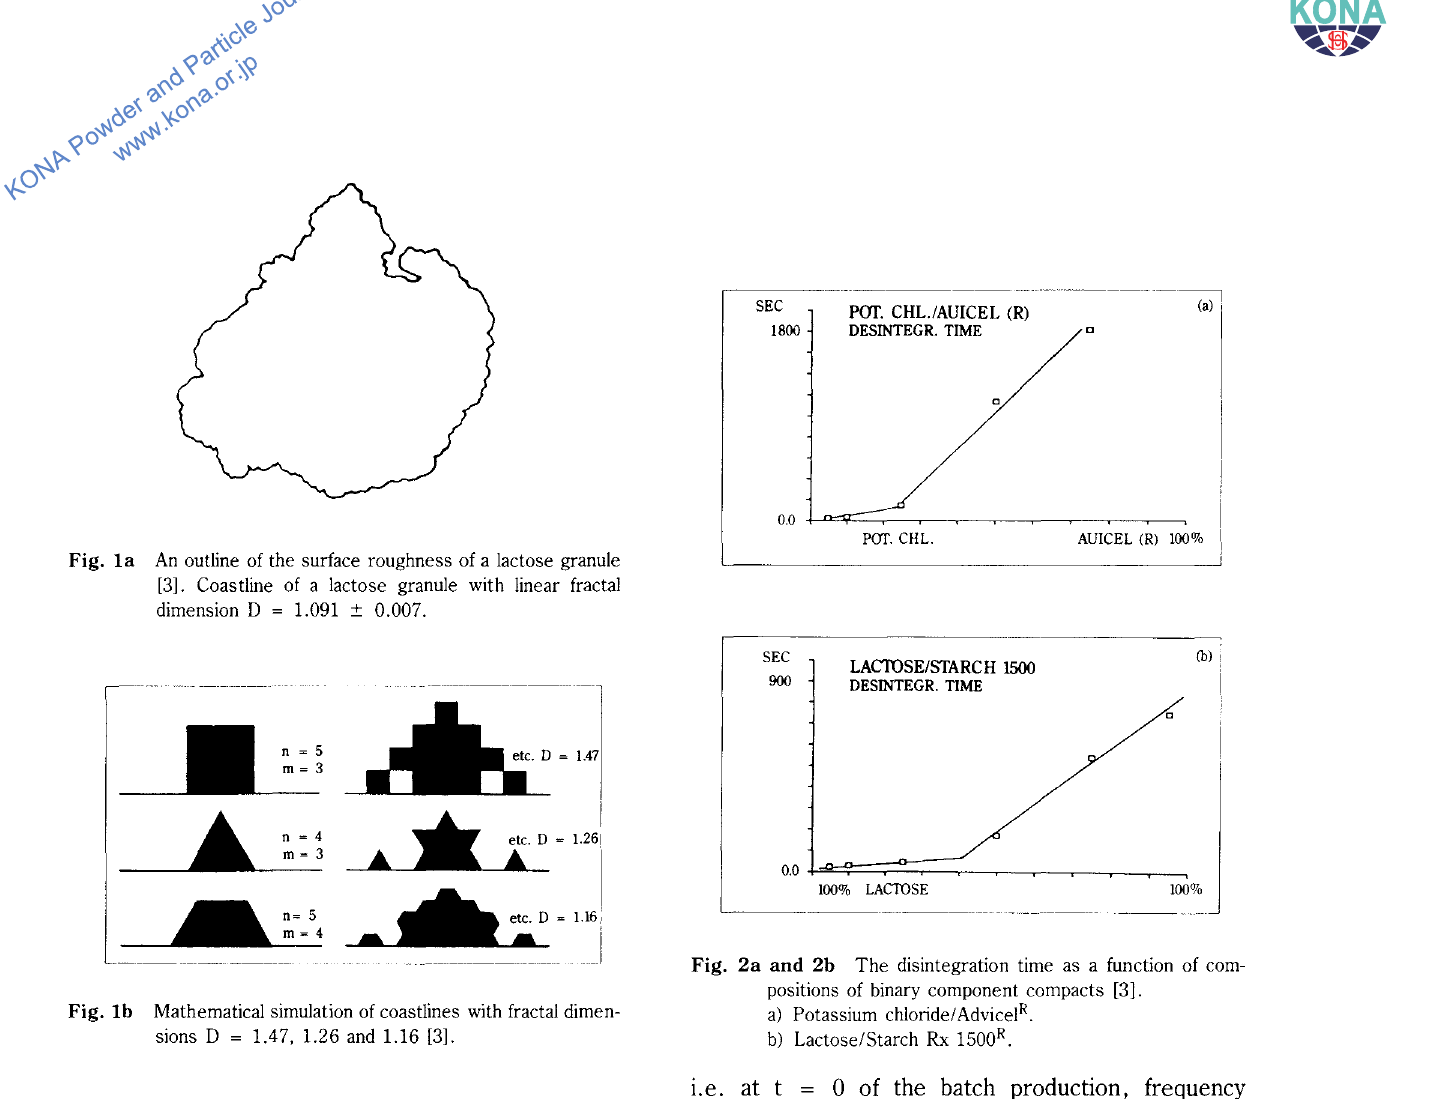
Fig. lb Mathematical simulation of coastlines with fractal dimen sions D = 1.47, 1.26 and 1.16 [3].